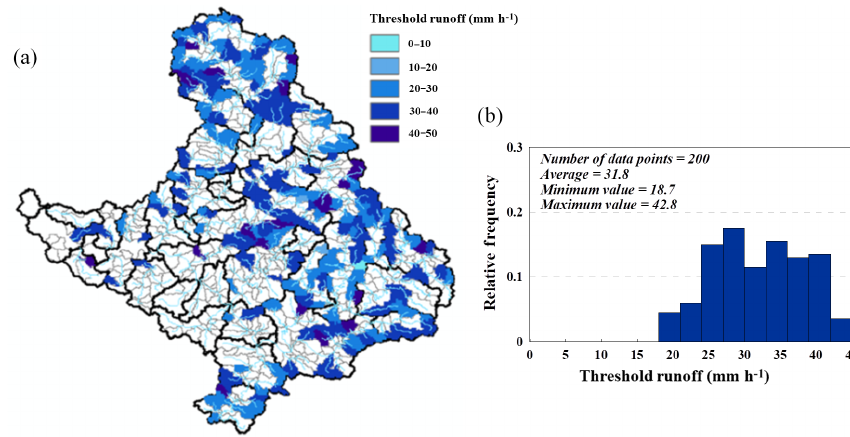
Figure 5. (a) Threshold runoff and (b) its relative frequency.